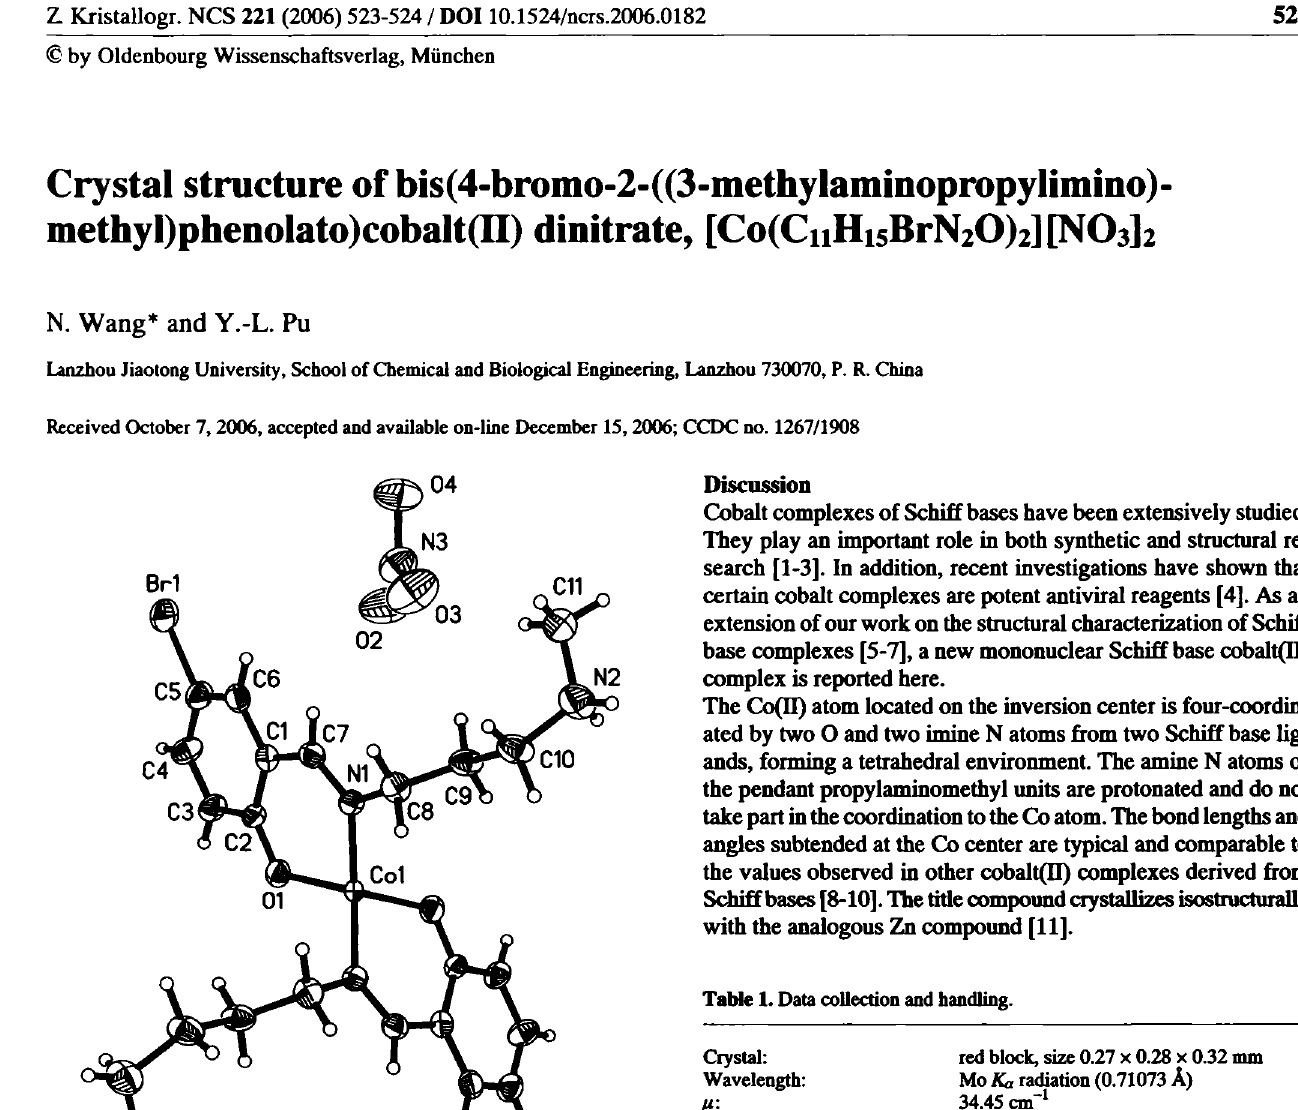
Table 1. Data collection and handling.